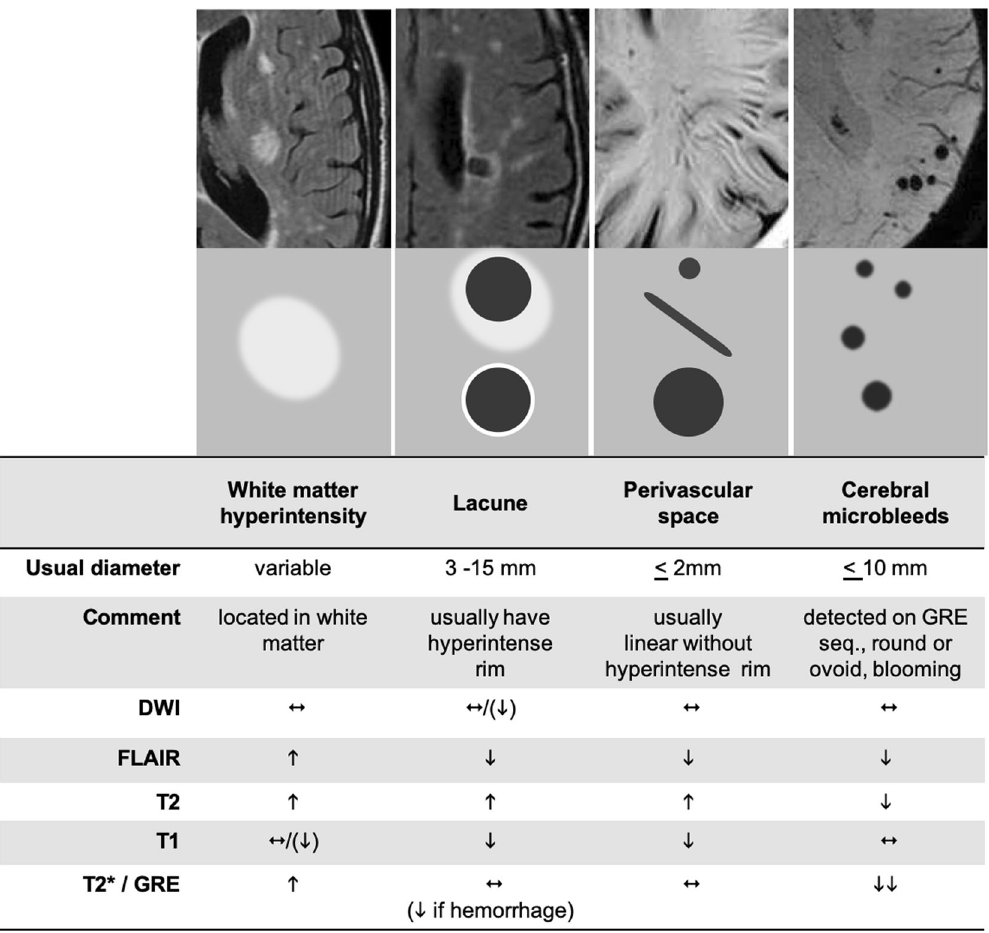
Fig. 1 Key radiological markers of SVD examined in this study. Examples and schematic representations of key radiological features of SVD, according to STRIVE guidelines [3]. Adapted with permission from ref. [3] [licence number 5094250830697, dated June 22 2021]. DWI diffusion- weighted imaging, GRE gradient-recalled